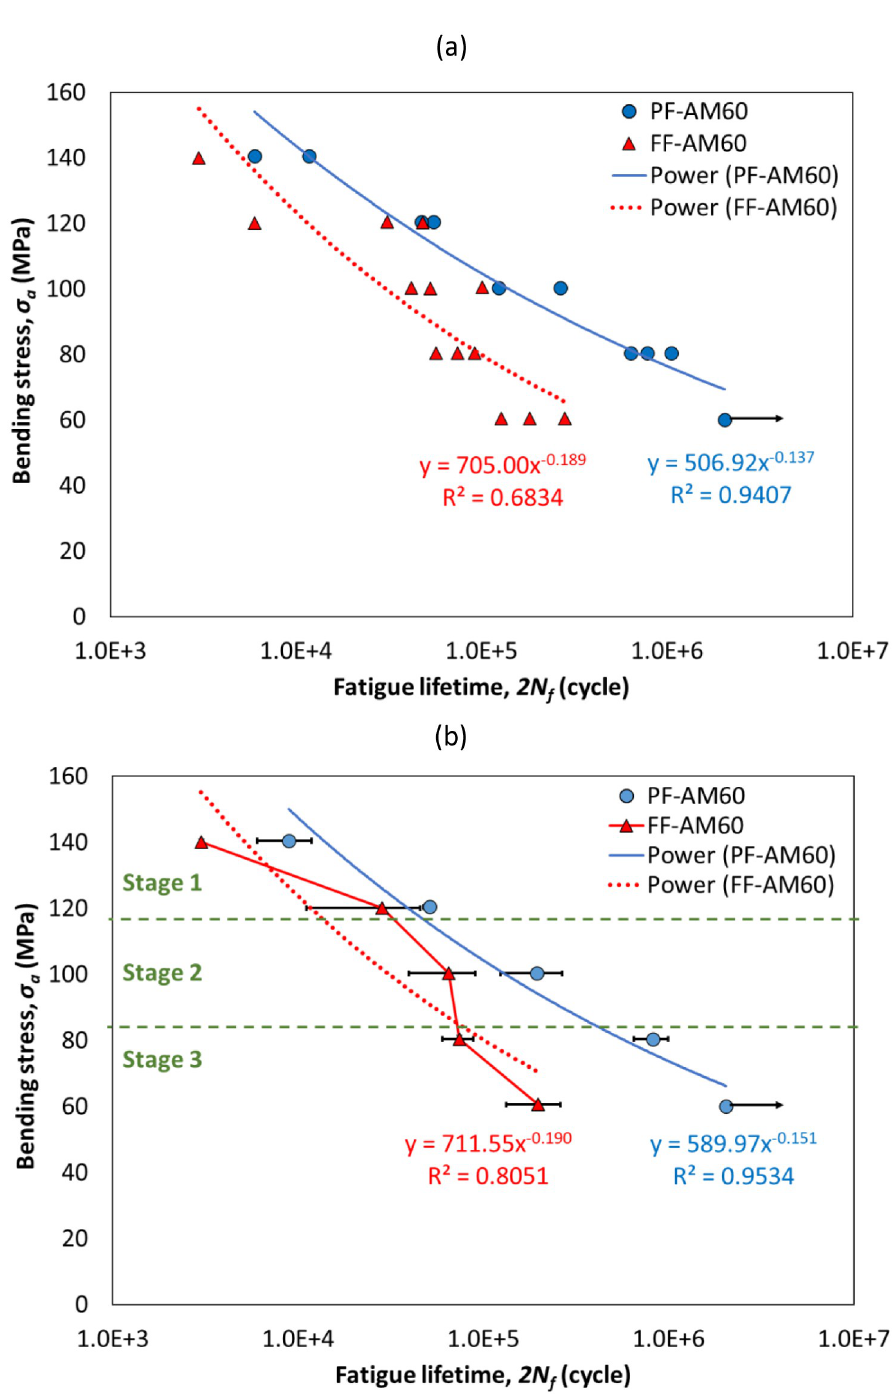
Fig 5. The data of pure fatigue (PF) and fretting fatigue (FF) for the bending stress versus the fatigue lifetime: (a) all raw data and (b) average values.